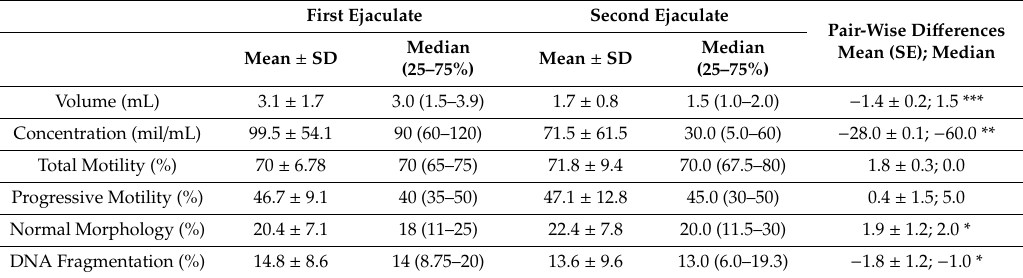
Table 1. Seminal fluid volume, conventional sperm parameters and DNA fragmentation of the two ejaculates in men with normal sperm parameters ( n = 30).